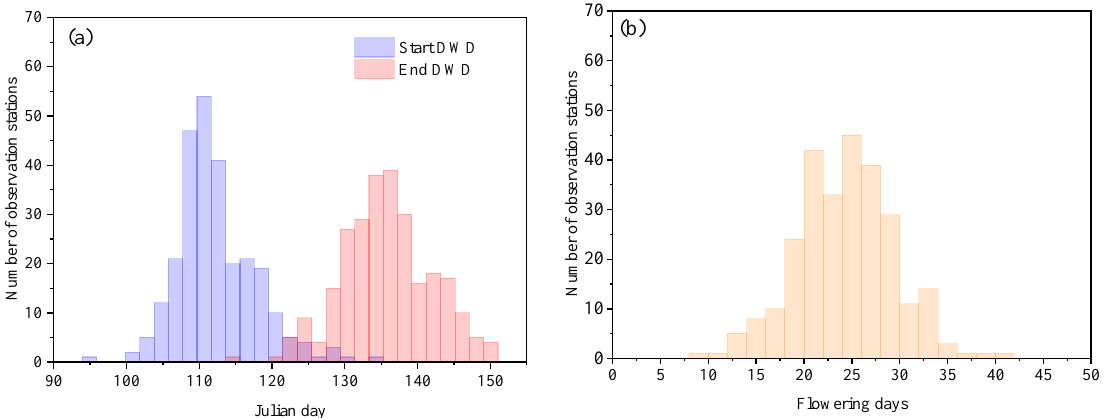
Figure 1. The start and end dates of flowering ( a ) and length of the flowering periods (flowering days) ( b ), for rapeseed based on Germany’s national meteorological service (the Deutscher Wetterdienst, DWD) observations. The y-axis represents the number of observation stations. The x-axis of ( a , b ) represent Julian day and flowering days, respectively.